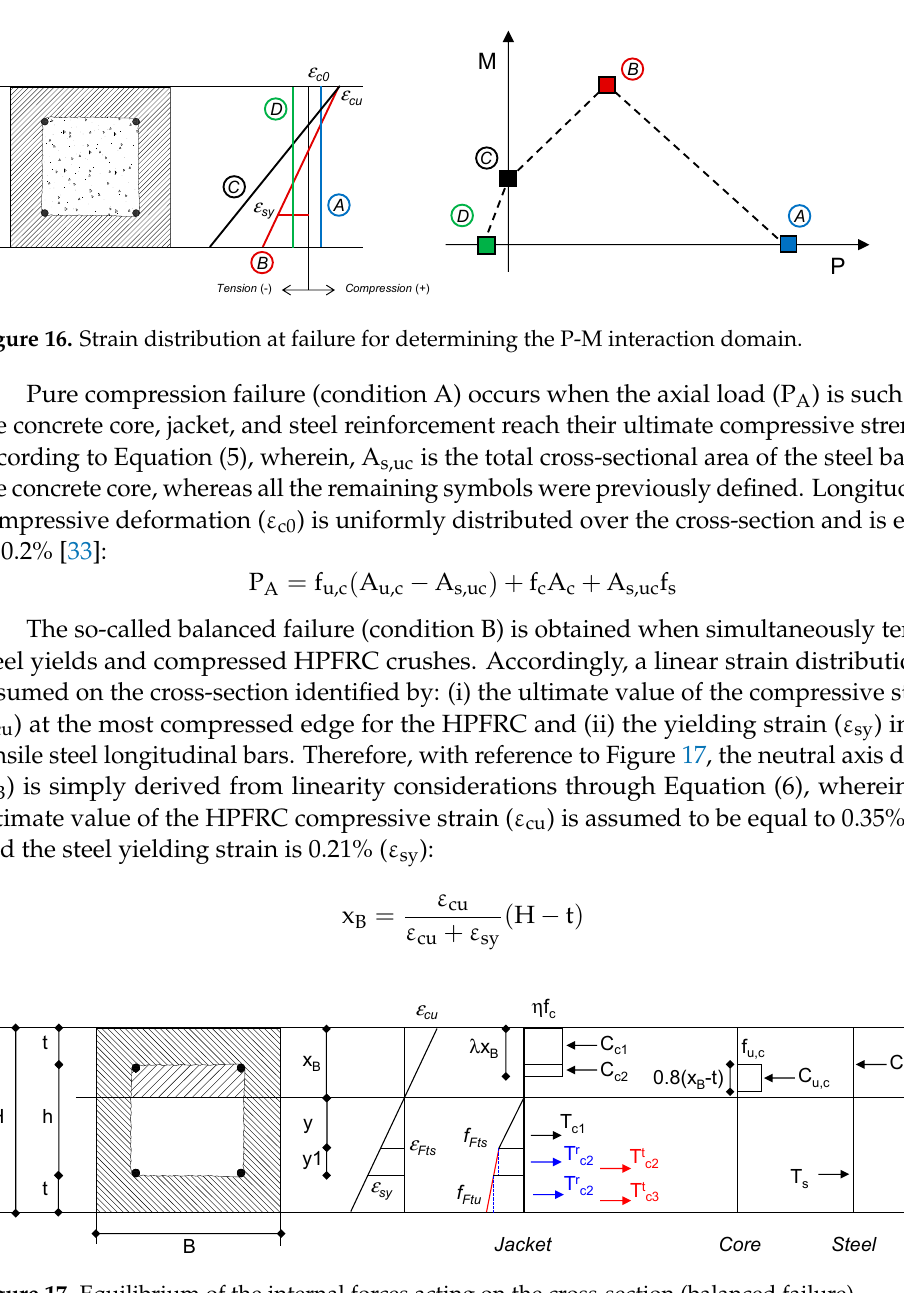
Fts and f Ftu are equal to 6.0 and 9.3